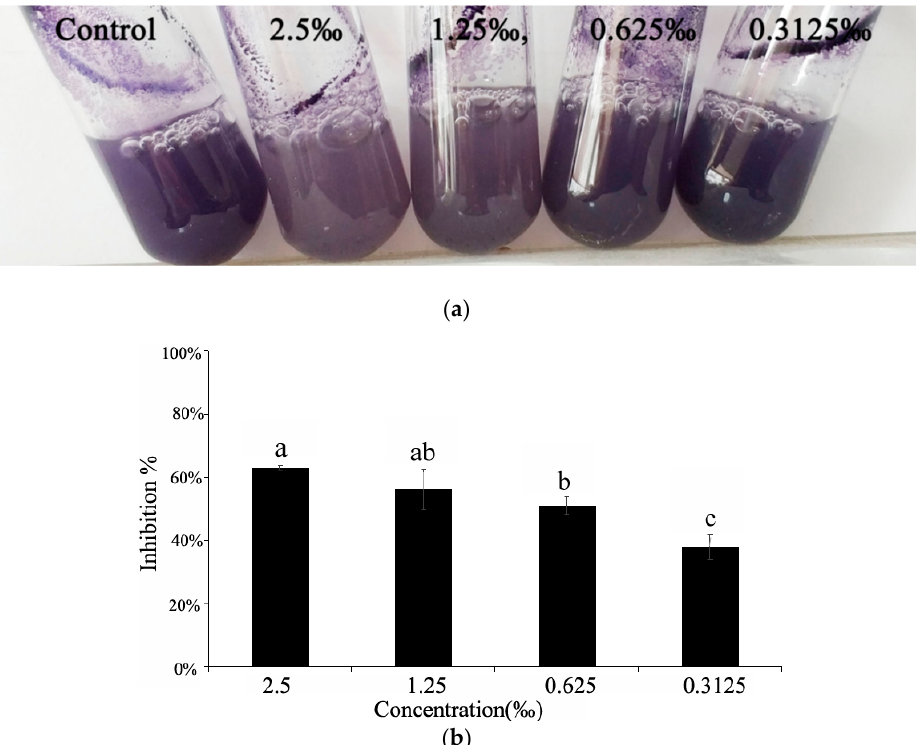
Figure 4. The effect of different concentrations of C. camphora EO on the production of violacein. ( a ) Effect of C. camphora EO on violacein production in C. violaceum . ( b ) Quantitative analysis of violacein inhibition in C. violaceum by C. camphora EO. Mean values of triplicate independent experiments and SD are shown. Bars indicate standard errors and different letters ( a – c ) above the bars represent significant differences ( p < 0.05).